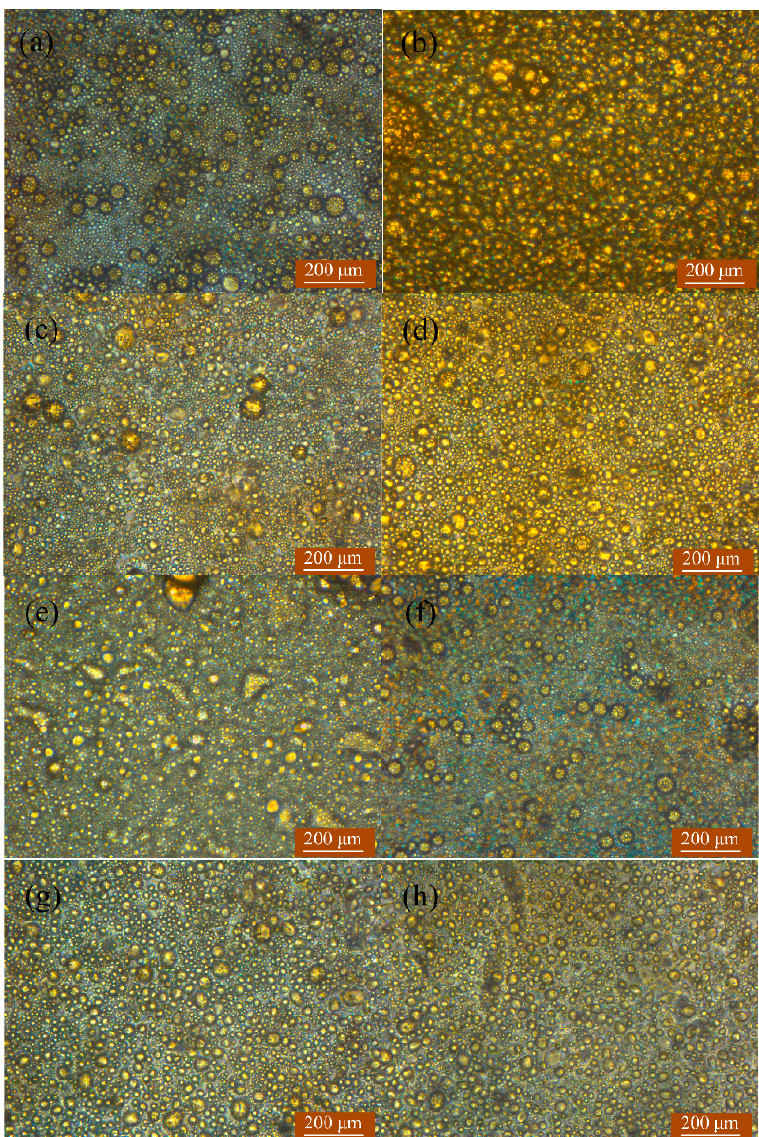
Figure 5. Photomicrographs of emulsions captured at 37 mm and 65 mm from the inlet ( a ) Emulsion I, TAPM A, 37mm; ( b ) Emulsion I, TAPM A, 65mm; ( c ) Emulsion II, TAPM A, 37mm; ( d ) Emulsion II, TAPM A, 65mm; ( e ) Emulsion II, TAPM B, 37mm; ( f ) Emulsion II, TAPM B, 65mm; ( g ) Emulsion III, TAPM A, 37mm; and ( h ) Emulsion III, TAPM A, 65mm.